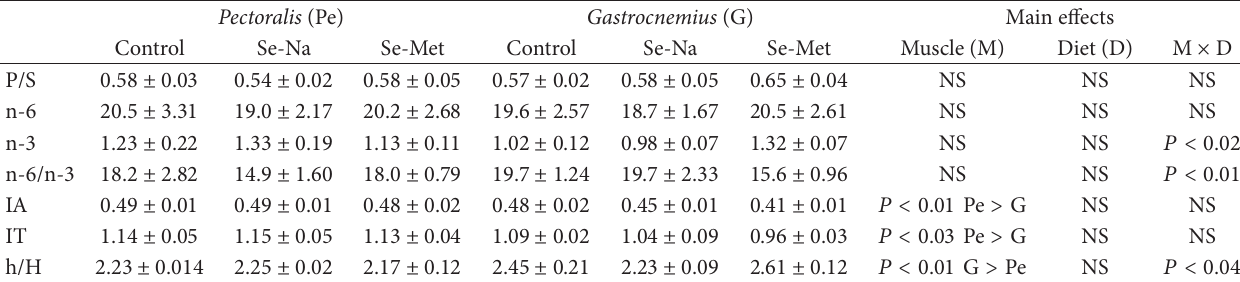
Table 3: Calculated lipids indices in terms of the health needs of consumers for Pectoralis and Gastrocnemius muscles of chickens supplemented in diet with inorganic (Se-Na) or organic (Se-Met) selenium. Pectoralis (Pe)